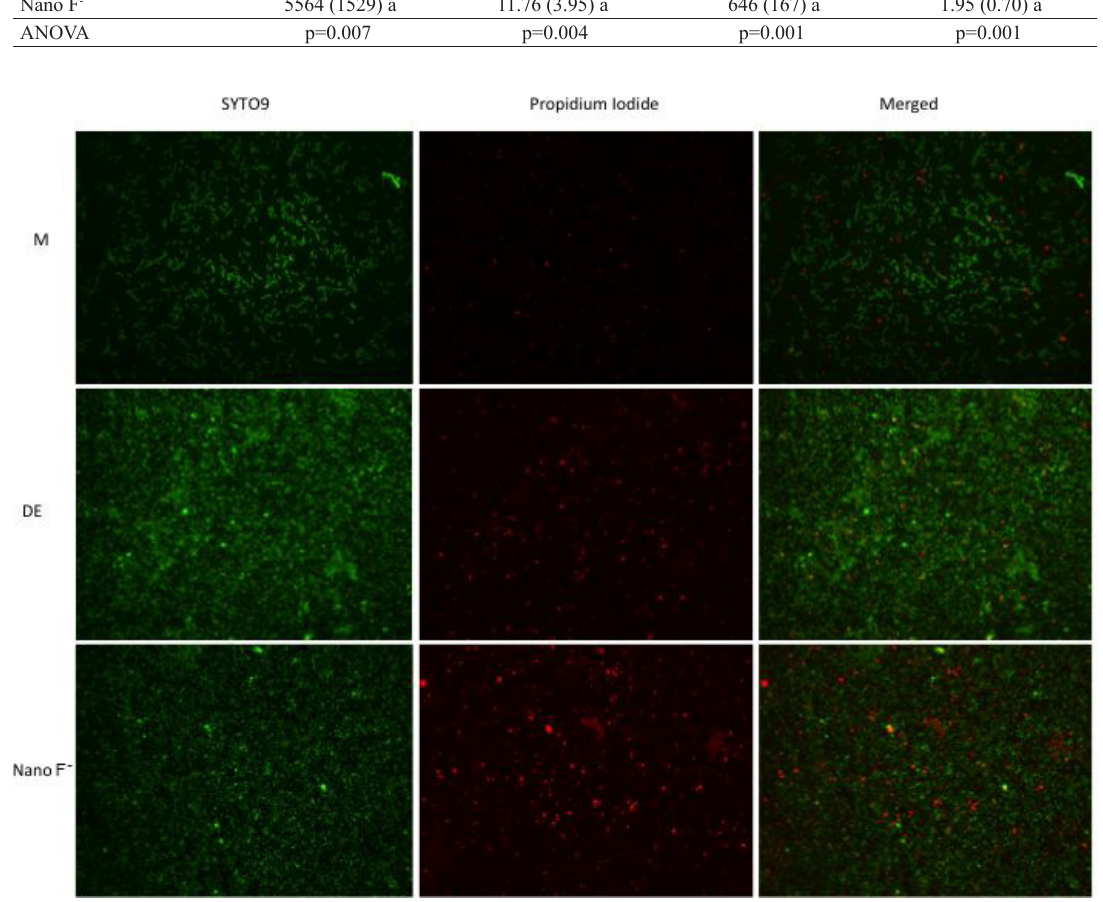
Figure 2. S. mutans fluorescence microscopy micrographs on M (A), DE (B) and Nano F - (C) surfaces. SYTO9 (green) represented live bacteria; Propidium iodine (red) labeled dead bacteria and Merged (green + red) stained live and dead bacteria. Magnification 100X.